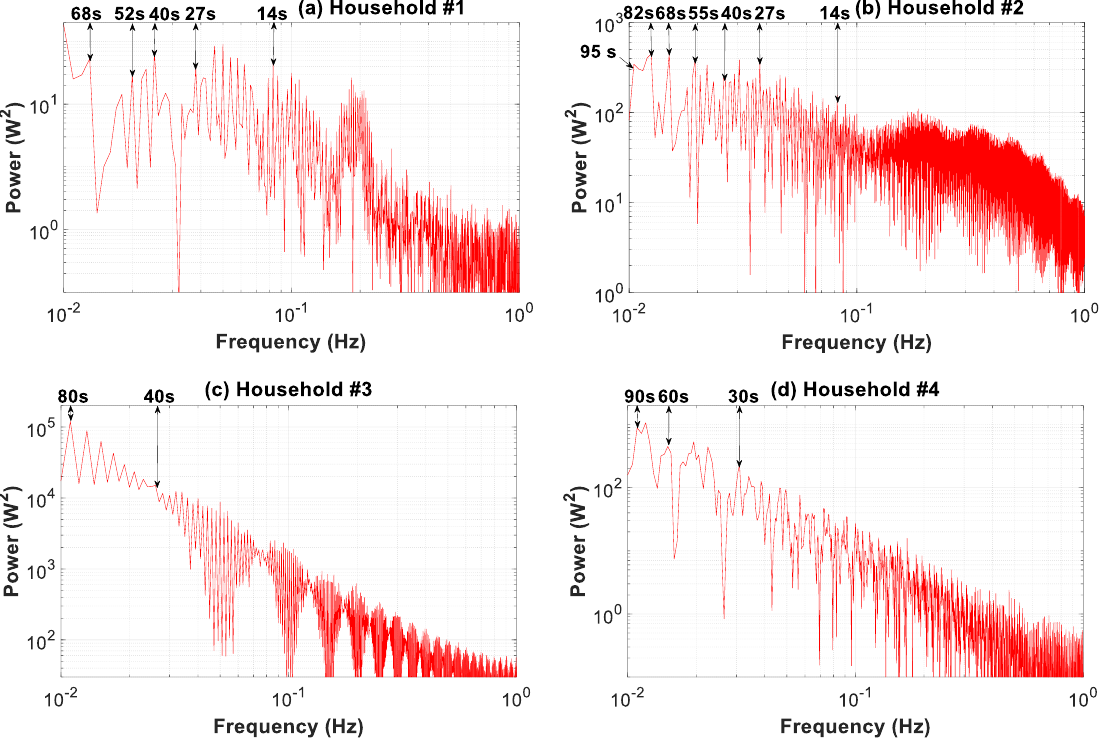
Figure 13. Periodogram of the consumption load profile for households #1 to #4: 1–100 s time slice.